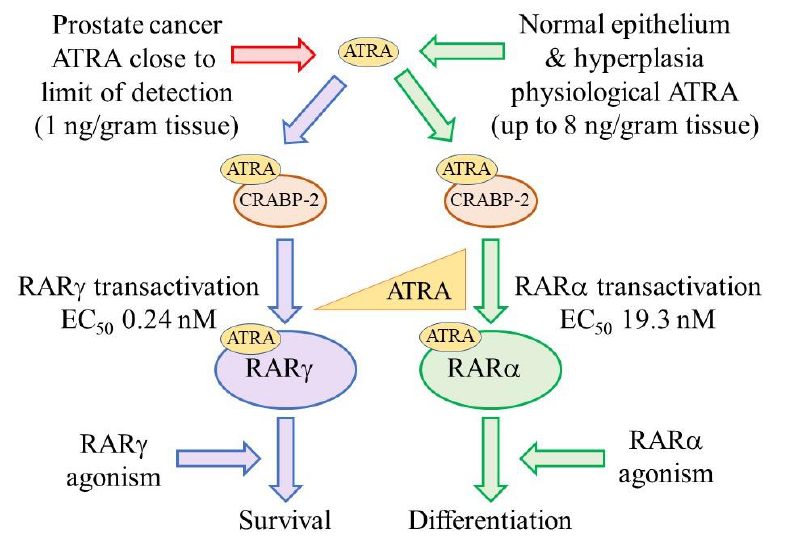
Figure 1. Patients PCa cells survive and grow in an abnormally low level of ATRA. The low level of ATRA within PCa tissue is important because 0.24 nM ATRA transactivates RAR γ , whereas RAR α transactivation requires a much higher concentration of 19.3 nM ATRA. Patients’ PCa cells are, therefore, reliant on RAR γ transactivation for survival and proliferation. From various studies, active RAR γ is pro-survival whereas active RAR α is pro-differentiation.